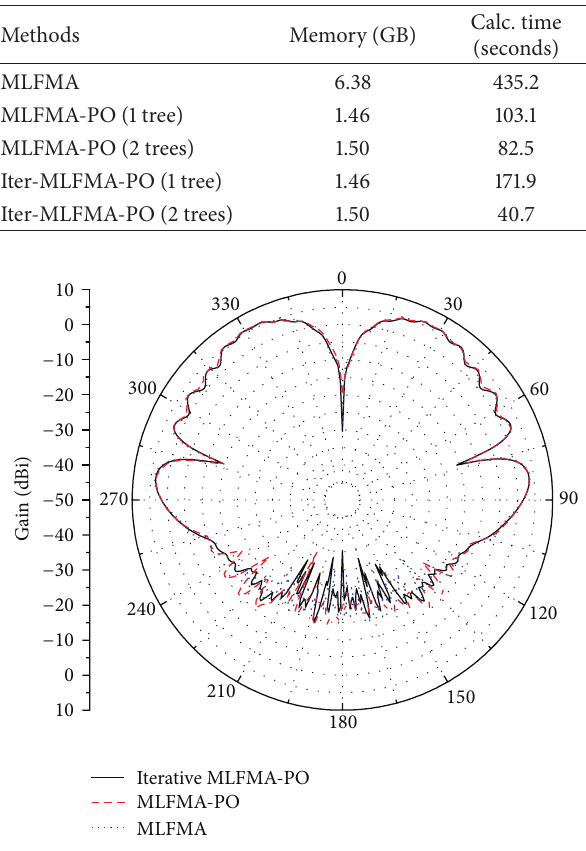
Figure 3: The far-field gain pattern in XOZ plane of the monopole mounted on the